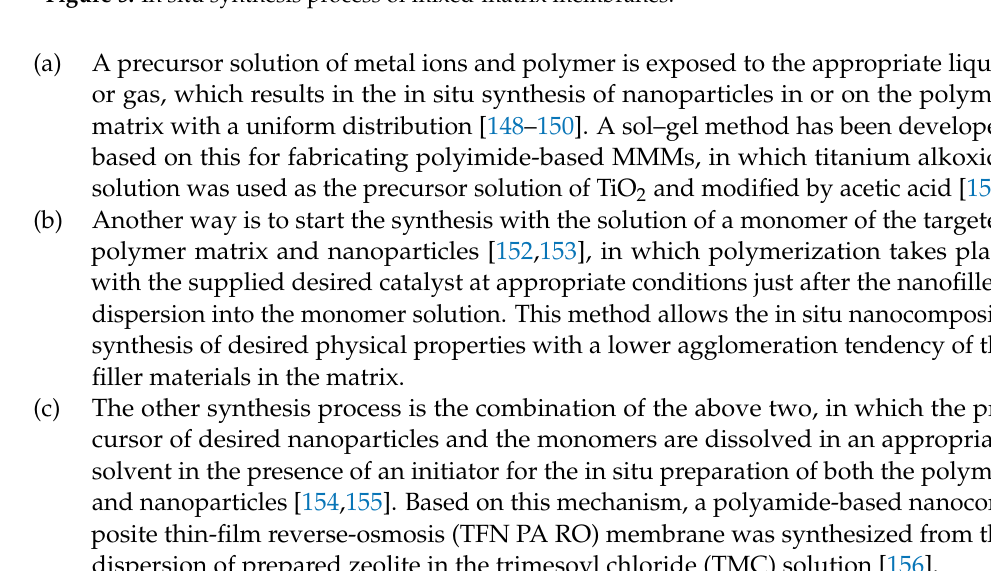
Table 2. Basic properties of some membranes with their fabrication process.